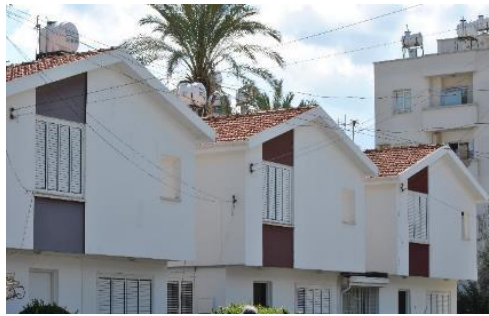
Figure 19. The Clean, abstract and White surfaces for Efruz Housing (Image by Author,